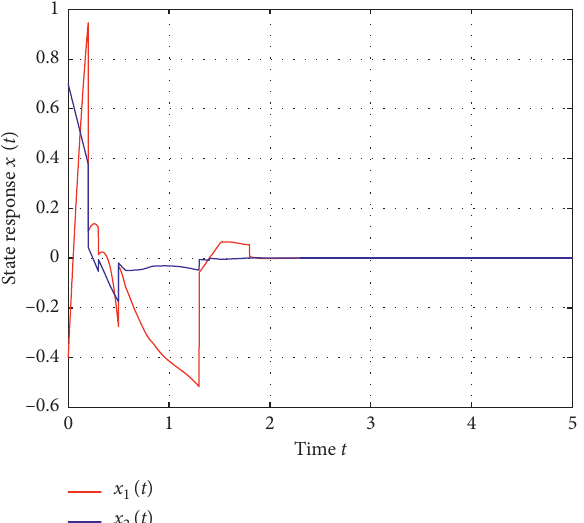
Figure 8: Curve of x ( t ) with AEIC for Example